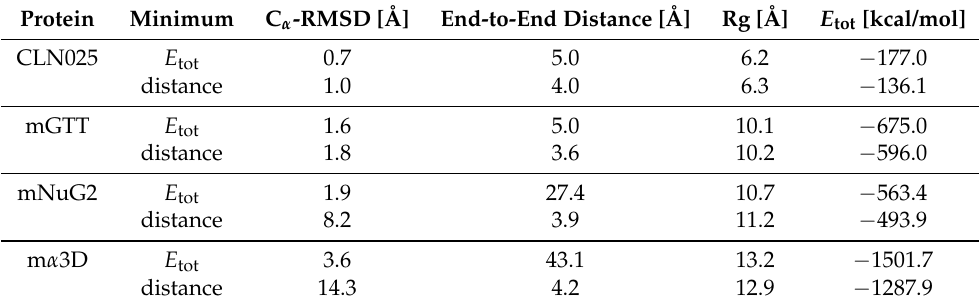
Table 2. C α -RMSD, the end-to-end distance, the radius of gyration (Rg), and the total energy of the lowest-total-energy ( E tot ) and the shortest end-to-end distance (distance) structures for each protein in Figure 2.